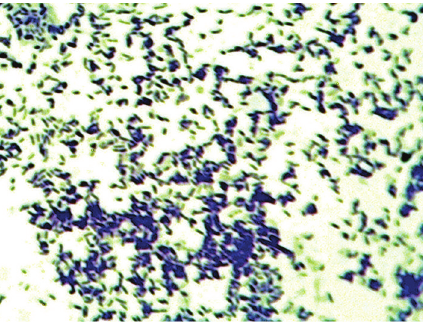
Figure 7: Electron microscope for the STGs at 50000x.